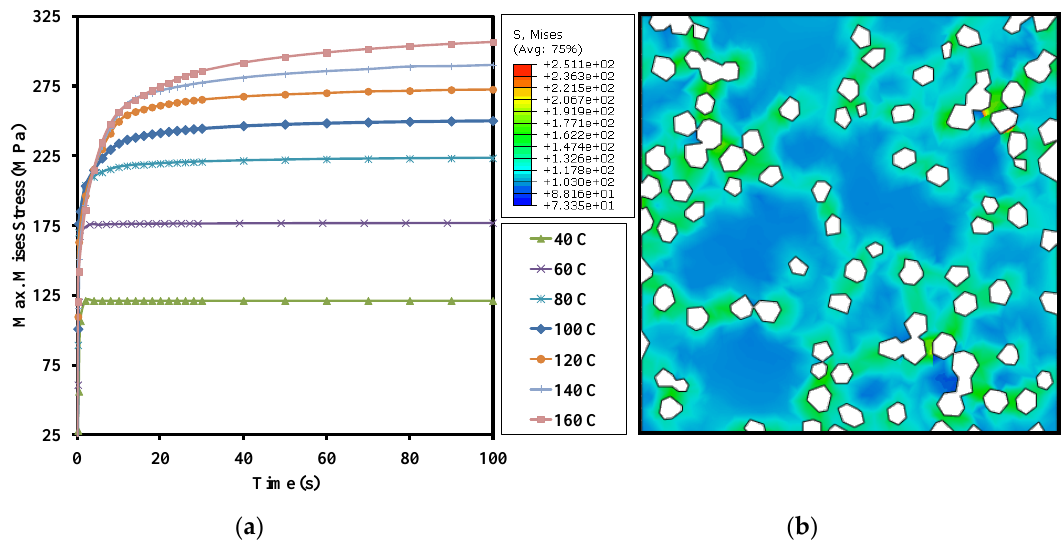
Figure 10. Case 4: Maximum von Mises equivalent stress as a function of time for different temperature values ( a ); Contours of Mises stress at the end of cyclic loading for a peak temperature of 100 °C ( b ).